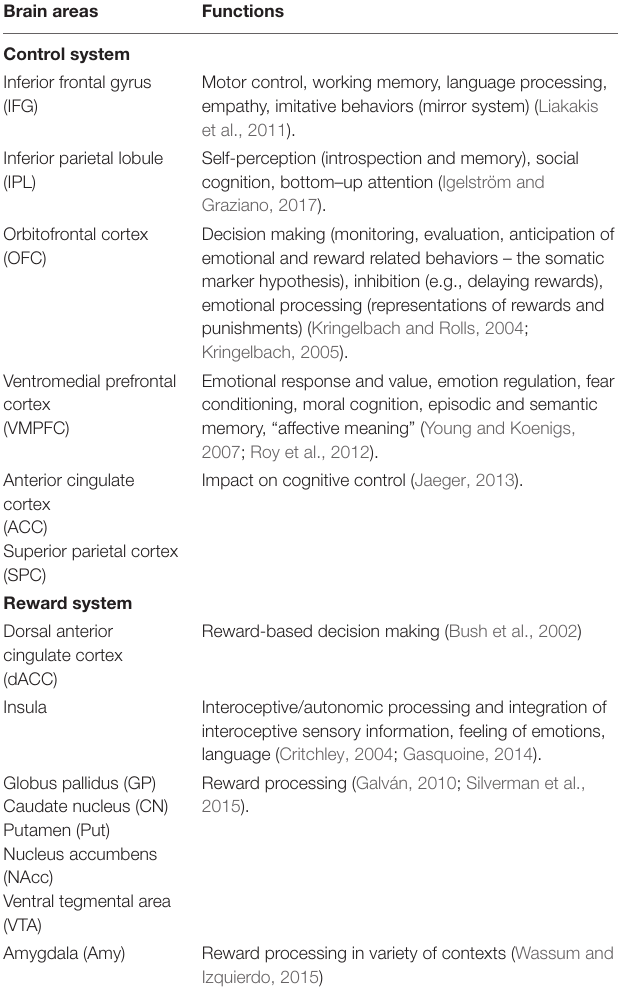
TABLE 1 | Summary of cortical and subcortical areas mainly involved in control and reward systems in the research on screen time in adolescence. Brain